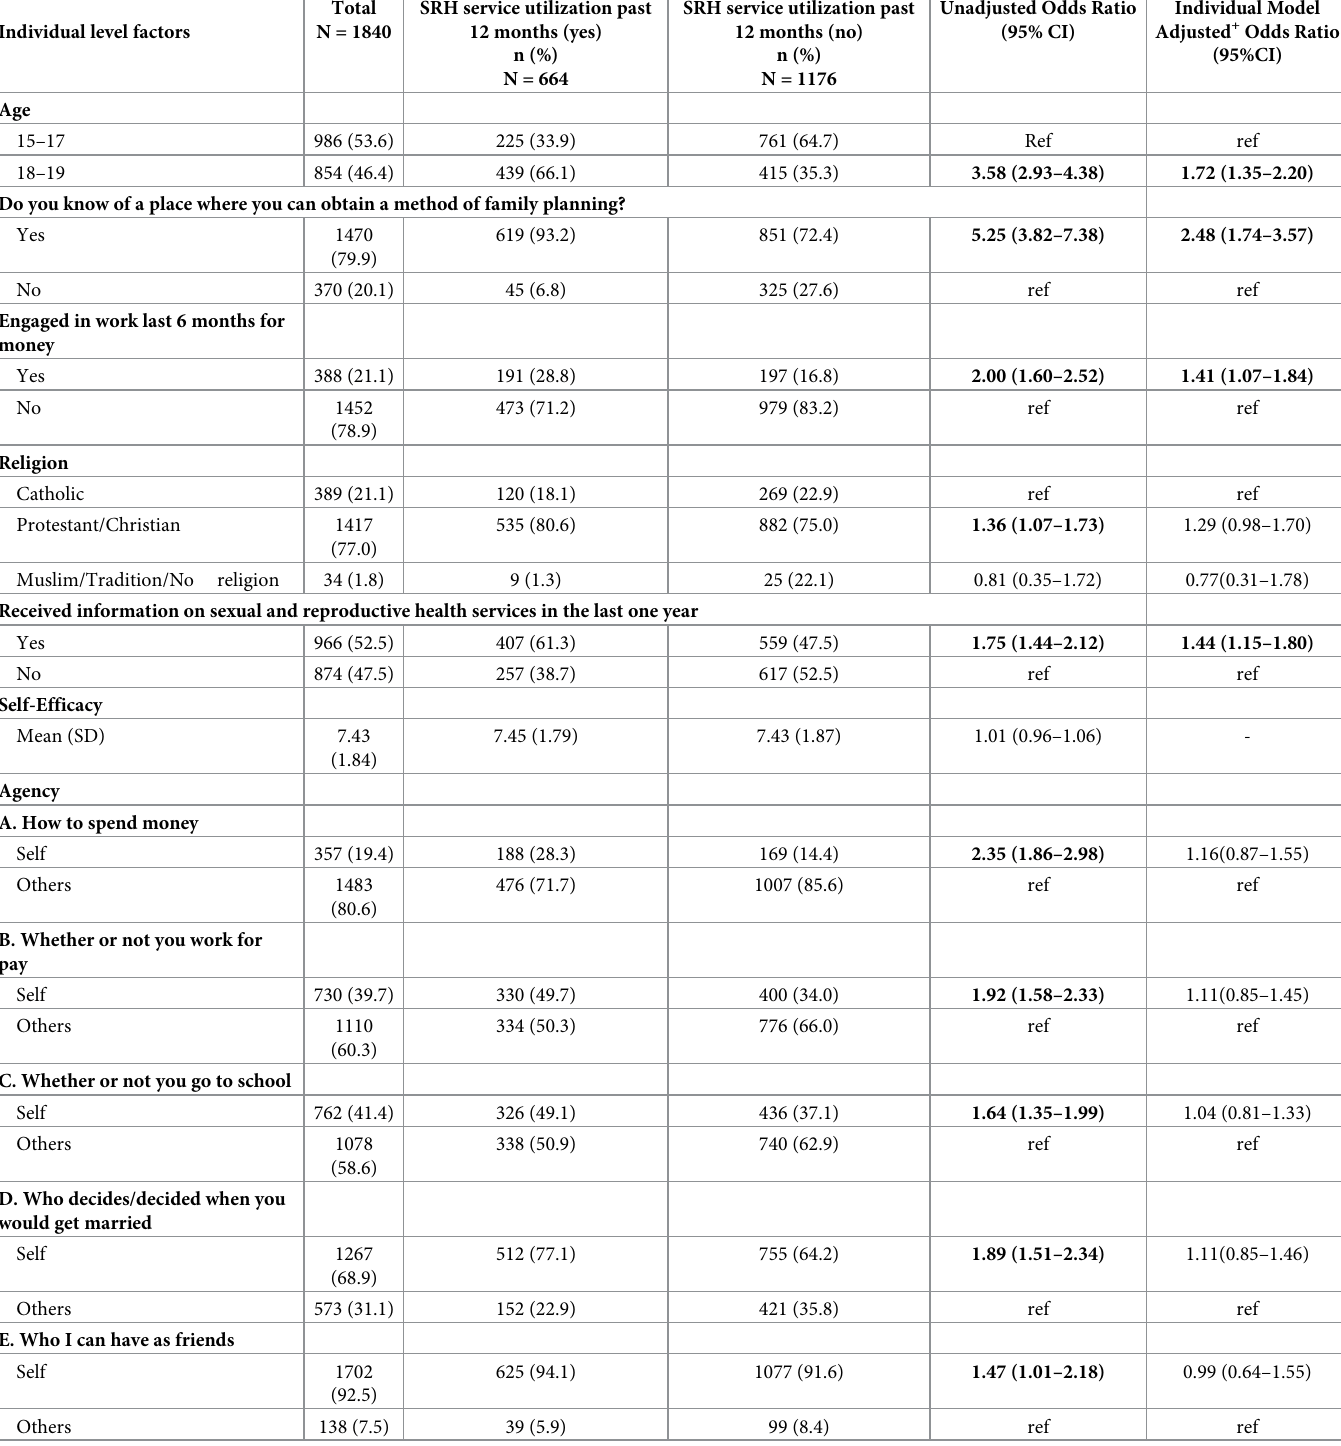
Table 5. Individual level factors associated with SRH utilization among adolescents aged 15–19 in